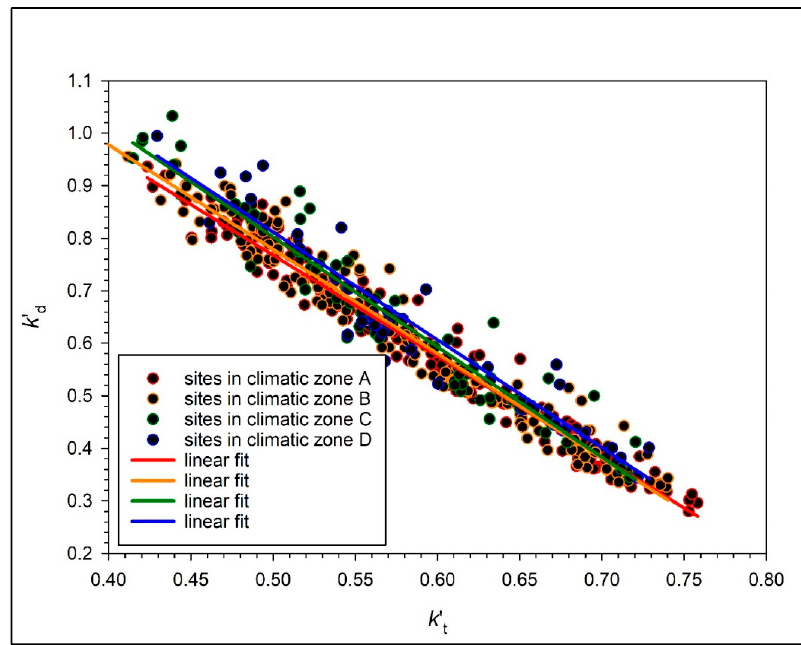
Figure 8. Monthly mean k ’ d vs. k ’ t data pairs for sites belonging to the same climatic zone under all-sky conditions in TATY and their best-fit lines. Linear regression equations for (i) climatic zone A: k ’ d = 1.730 − 1.925 k ’ t , R 2 = 0.97; (ii) climatic zone B: k ’ d = 1.774 − 1.989 k ’ t , R 2 = 0.96; (iii) climatic zone C: k ’ d = 1.851 − 2.097 k ’ t , R 2 = 0.92; (iv) climatic zone D: k ’ d = 1.839 − 2.054 k ’ t , R 2 = 0.90. The lower R 2 values in the climatic zones C and D—and especially in D—are expected because of the fewer data points and harsher weather conditions at these sites in comparison to those in the other two climatic regions.